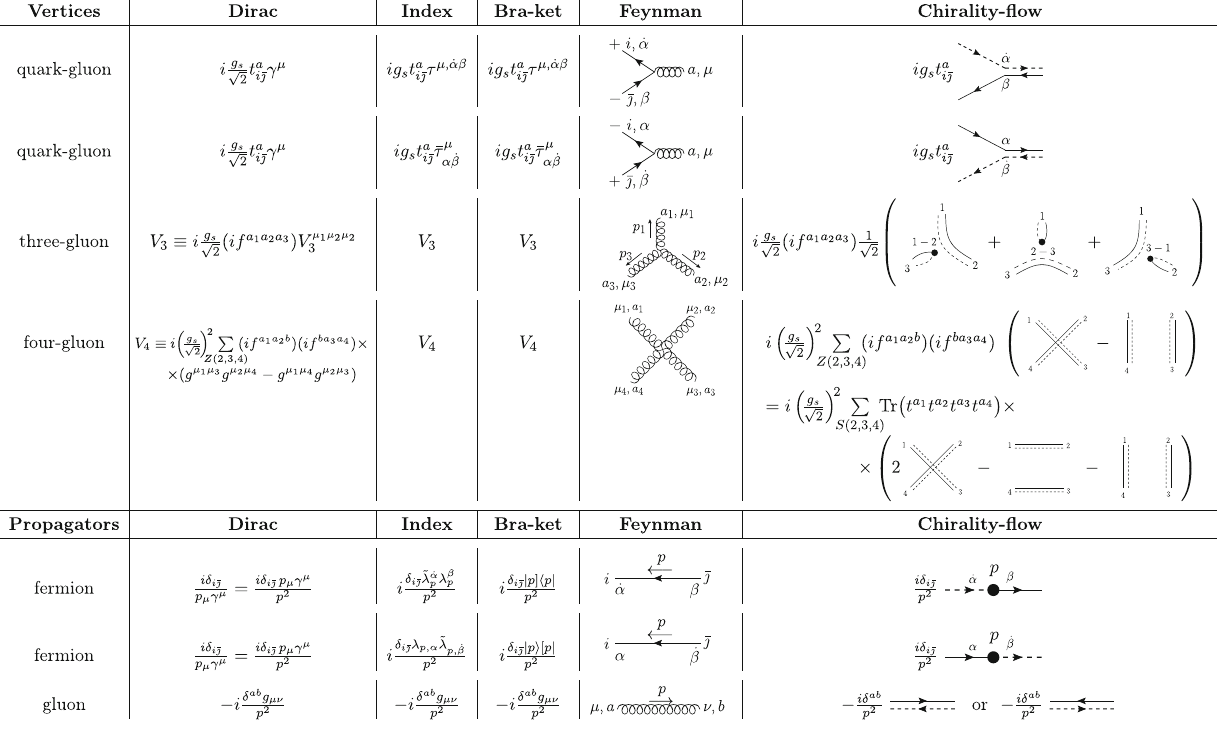
Table2 TheQCD“RosettaStone”translatingthechirality-flownotationtowidely-usedspinor-helicitynotations. V is given in (5.7). For more information, in particular on the various forms of the four-gluon vertex, see Sect. 5.1 (vertices) and 5.2